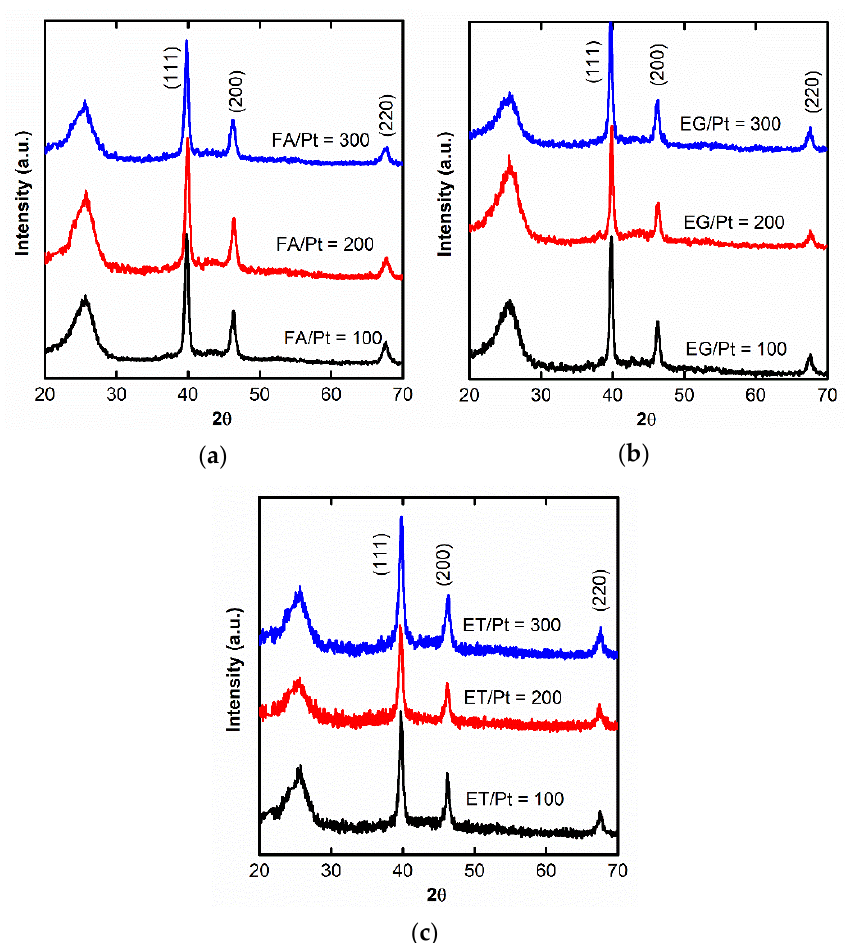
Figure 1. XRD patterns of the different electrocatalysts: ( a ) reduction with FA at 120 °C; ( b ) reduction with EG at 160 °C; ( c ) reduction with ET at 120 °C.